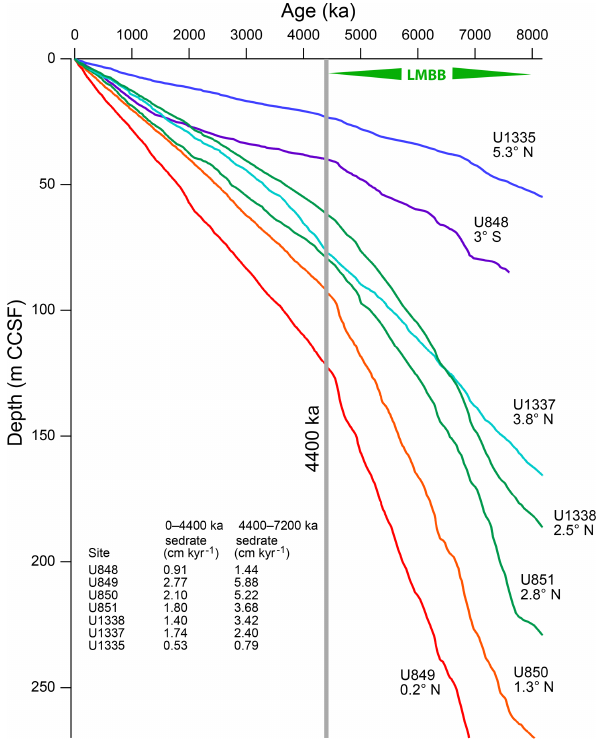
Figure 7. Age–depth curves for ODP Leg 138 and sites 848, 849, 850, and 851 with IODP Expedition 320/321 sites U1335, U1337, and U1338, based on the age model in this paper. Steeper slopes rep- resent faster sedimentation rates. Steepest slopes are found at sites that are nearest to the high productivity equatorial upwelling zone. Average sedimentation rates for the section younger than 4400ka and for rates between 7200ka (base of XRF section scanned in site 849) and 4400ka are tabulated. The break in sedimentation at the gray line at 4400ka marks the end of the LMBB. CCSF (compos- ite coring depth below sea floor) is the depth within the continuous spliced sediment section.